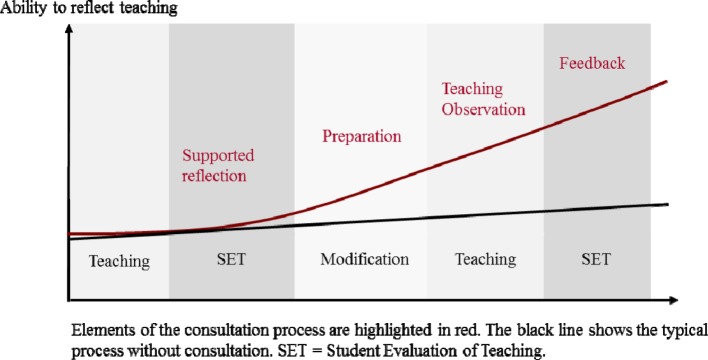
Process of the ITC